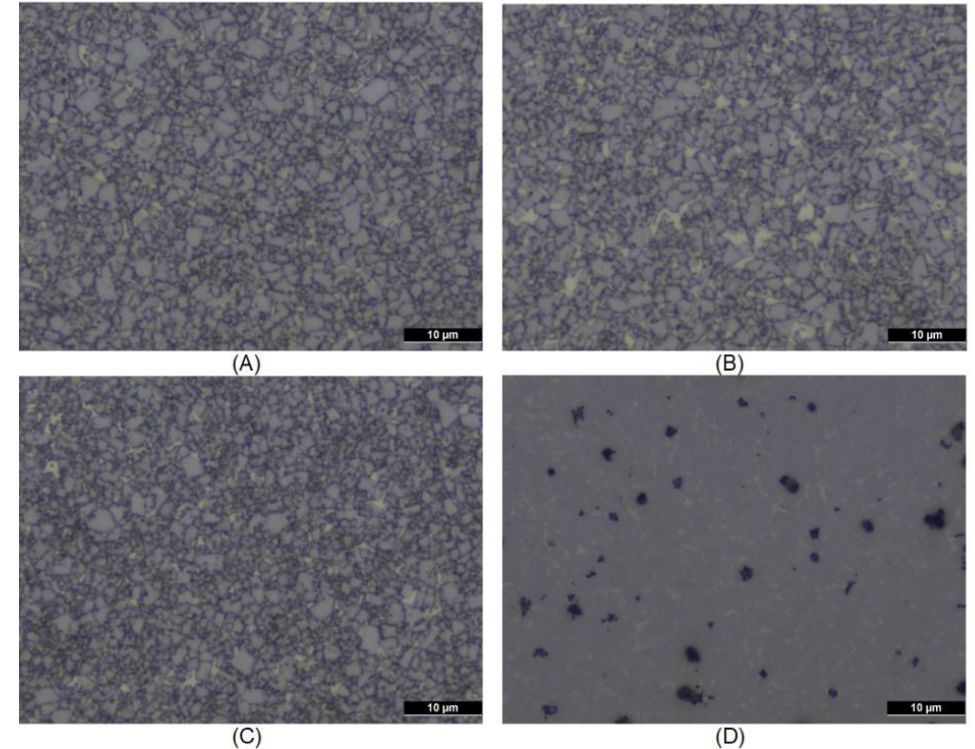
Figure 1. ( A – C ): the OM microstructures of grades of Table 1: A 1 (WC-6Co), B 1 (WC-9Co) and C 1 (WC-6CoRu), respectively; ( D ): distribution of γ -phase (HfC) in grade D 1 (WC-6CoHf).